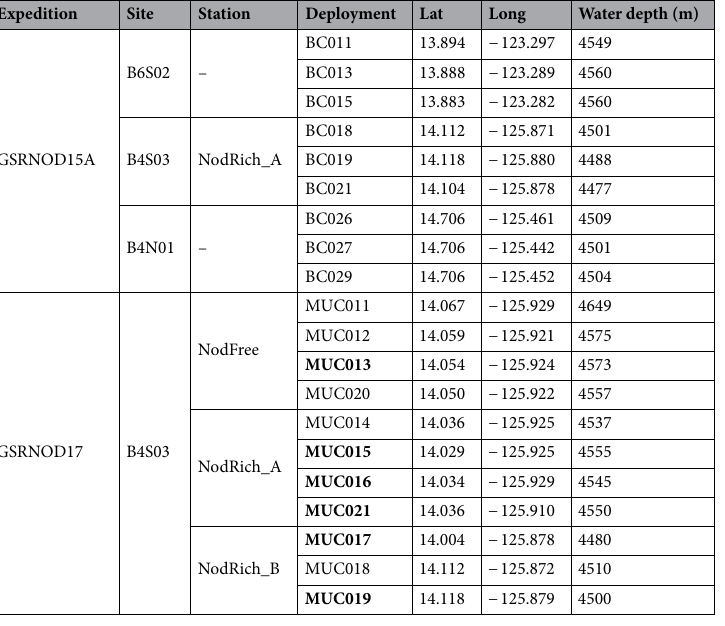
Table 1. Positions and depths of samples collected for this study in the GSR contract area. Only at site B4S03 different stations were delineated. Coordinates (lat, long) are expressed in decimal degrees. BC boxcorer, MUC multicorer. Boxcores were sampled for nodule crevice meiofauna, whilst MUCs were sampled for sediment meiofauna. MUCs denoted in bold were investigated for both sediment and nodule crevice